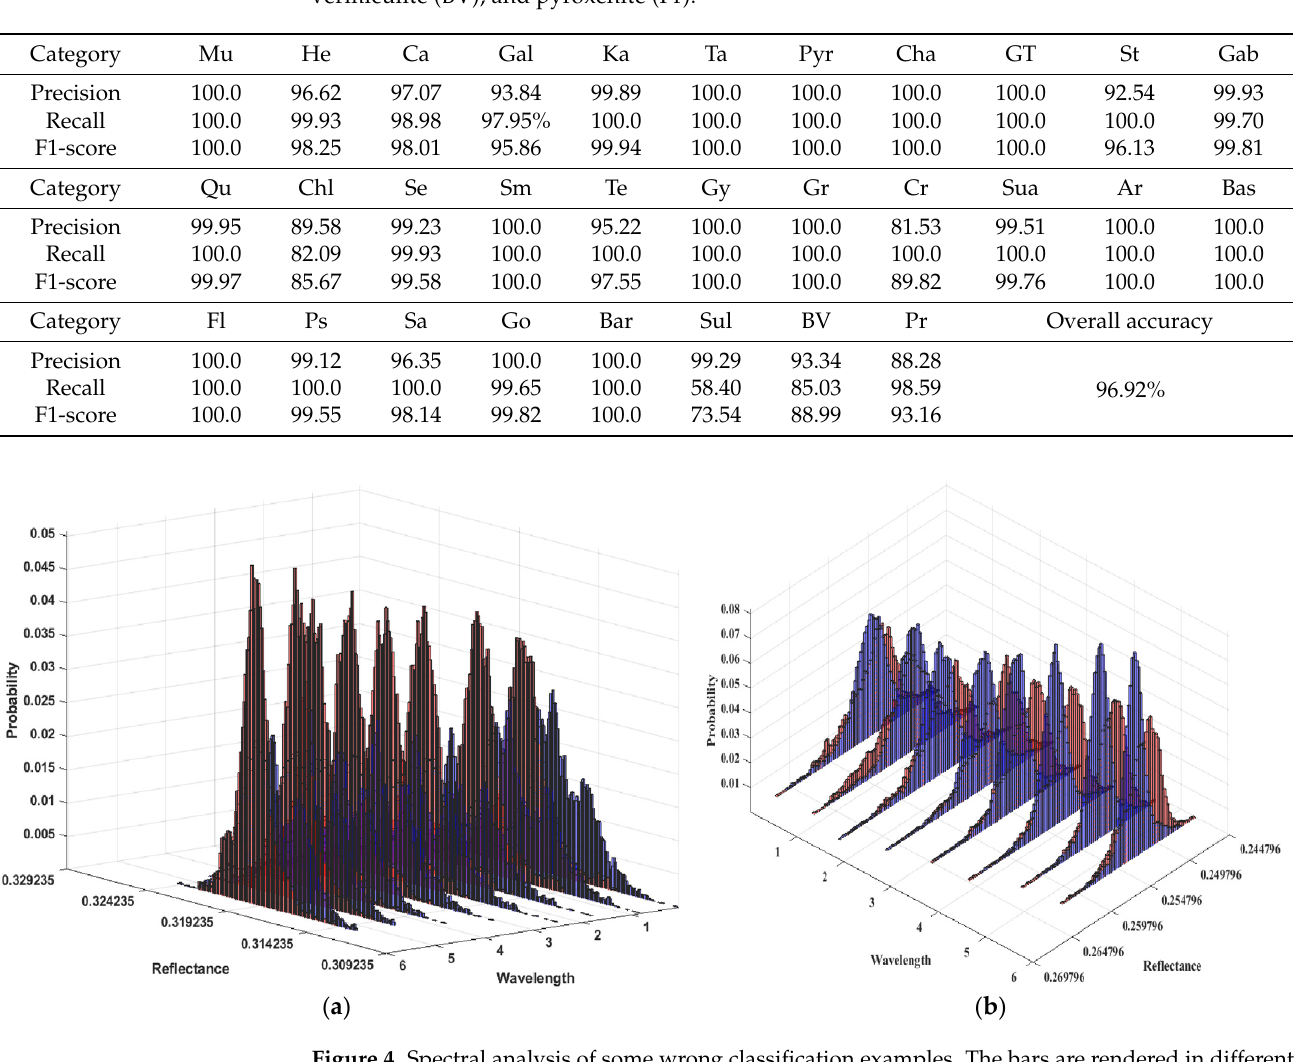
Table 3. Classification results generated by the developed method in precision, recall and F 1 − score per class as well as overall accuracy (the unit: %). For abbreviation, muscovite (Mu), hematite